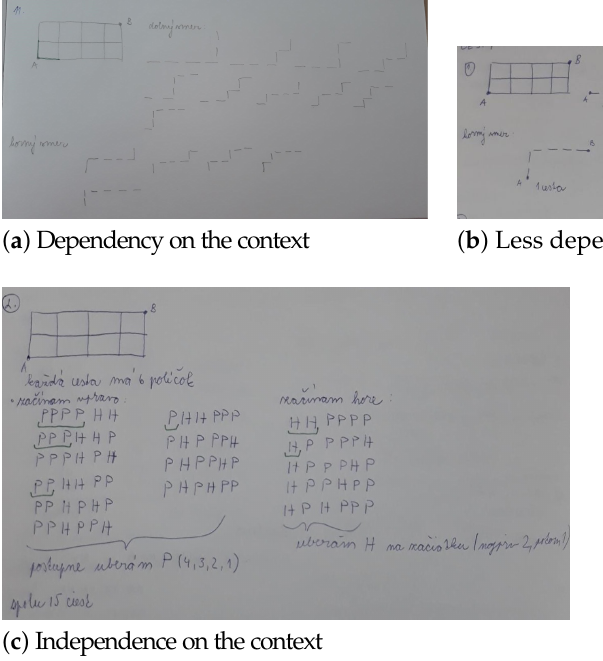
Figure 13. Refinement of the representation system for task 3.2